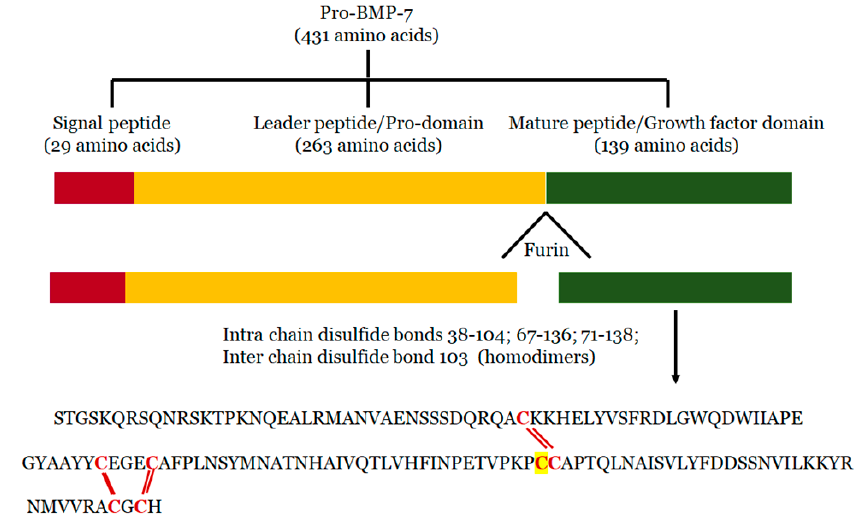
Figure 1. BMP-7 Structure: During processing, Pro-BMP-7 hydrolyzation by Furin on its carboxy terminal and converts into BMP-7 with three intra-chain disulfide bond forming cysteine residues and one inter-chain disulfide bond forming cysteine residue (highlighted).